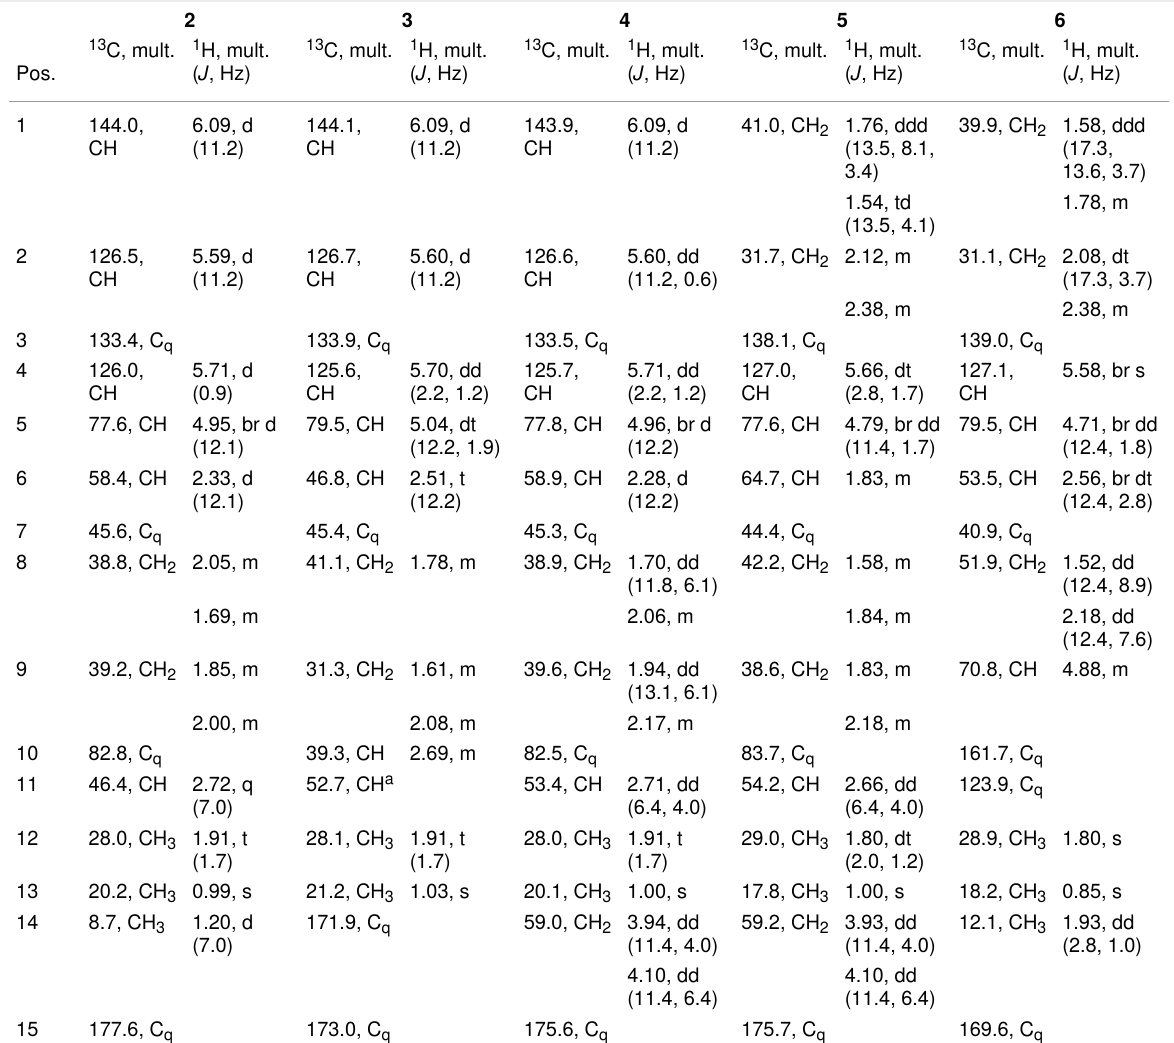
Table 1: NMR chemical shifts of compounds 2 – 6 ( 1 H NMR (700 MHz) and 13 C NMR (176 MHz) in methanol- d 4 .